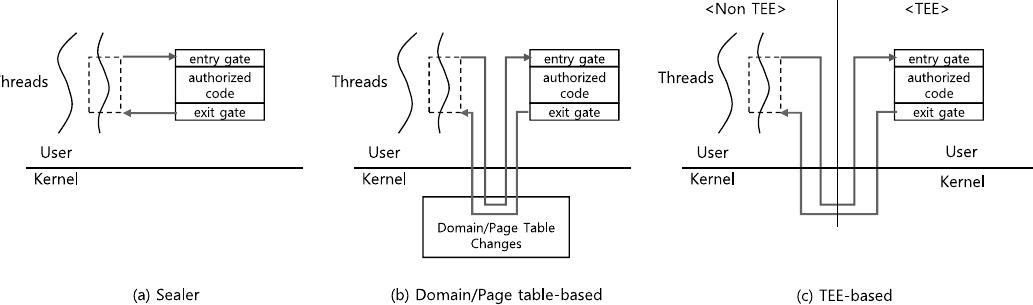
Figure 7. Comparison of mechanisms for data isolation. Isolation mechanisms based on the memory domain or page table require at least four privilege level changes to run the authorized code. In addition, those based on trusted execution environments (TEE) need not only four privilege level changes but also two secure state changes in order to run the authorized code in the TEE. On the contrary, Sealer allows the authorized code to run without specific changes in a privilege level or a secure state, enabling rapid execution of the